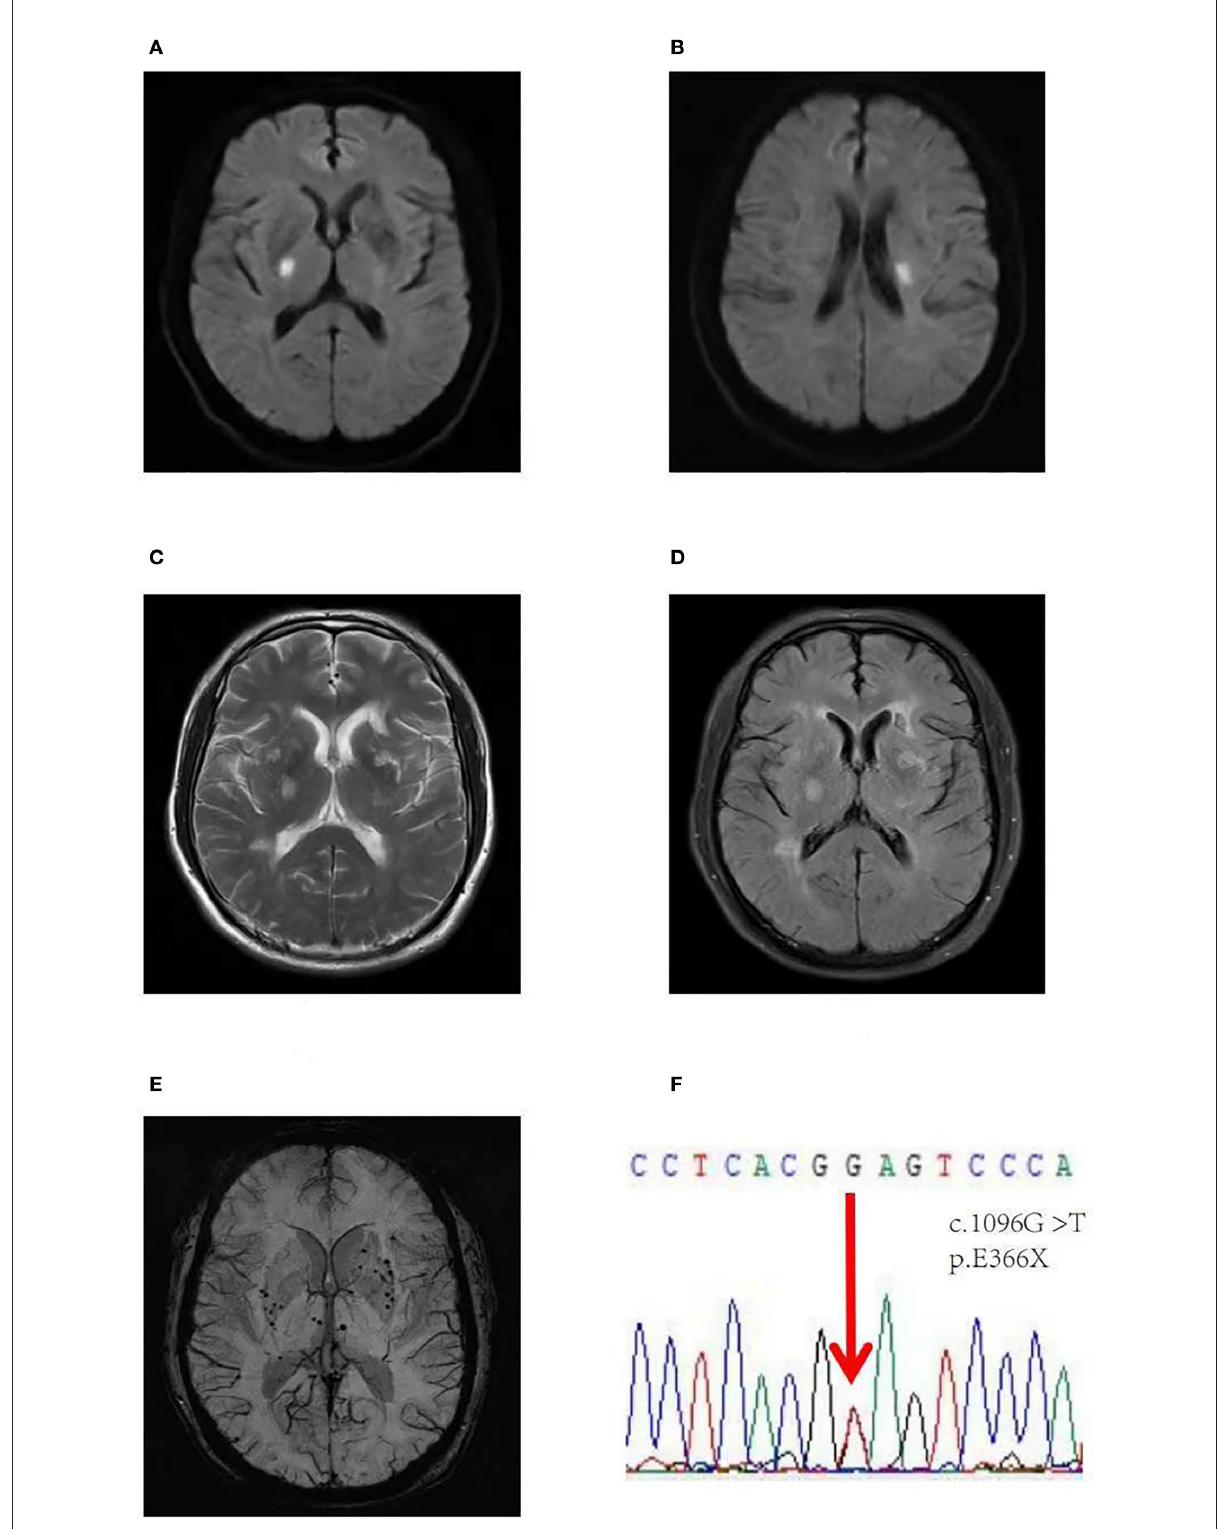
FIGURE1 Brain axial images of the first HTRA1 -CSVD patient. A DWI image showing an acute infarct in the right basal ganglia (A) , and the second acute infarct in the region next to the left lateral ventricle (B) , axial T2-weighted (C) , and FLAIR axial images (D) showing diffuse WMLs, Fazekas